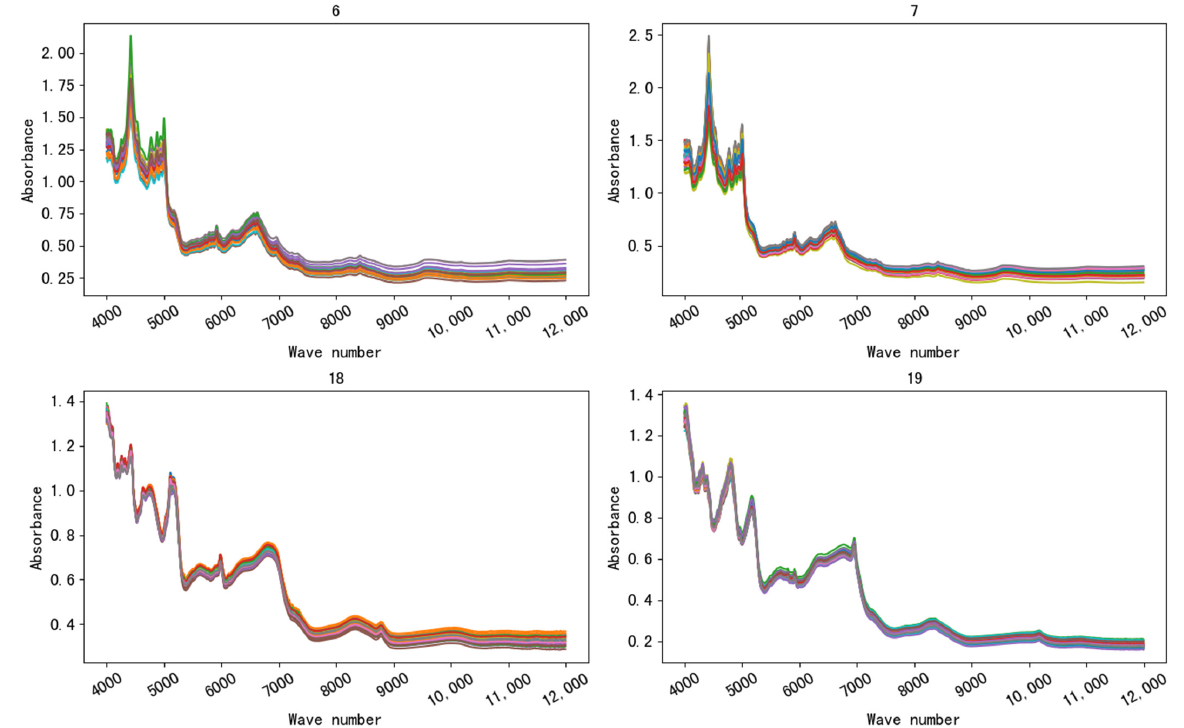
Figure 5. Similar spectra of the same drug produced by different manufacturers. Metformin hydrochloride tablets came from Nos. 6 and 7. Chlorphenamine maleate tablets came from Nos. 18 and 19.